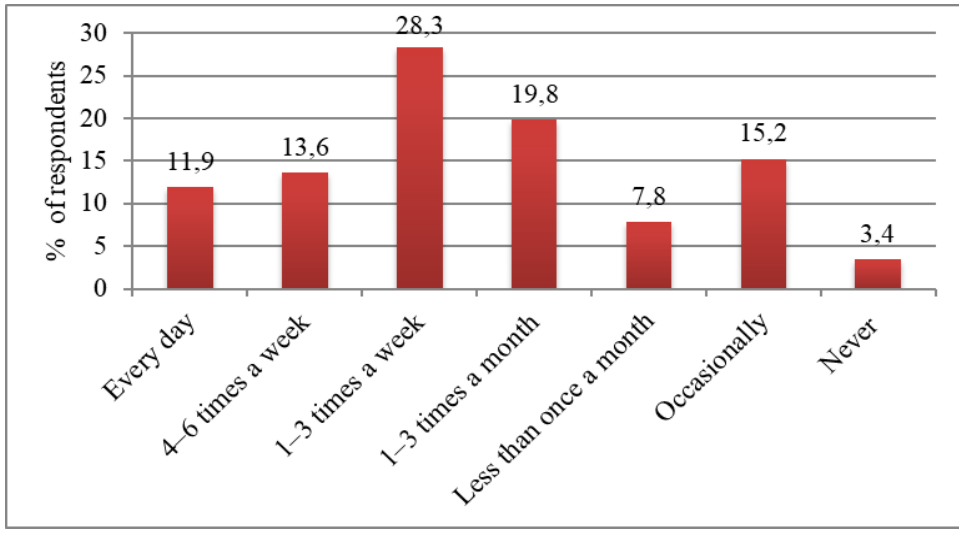
Figure 1. Frequency of consumption of citrus fruit juices by respondents.